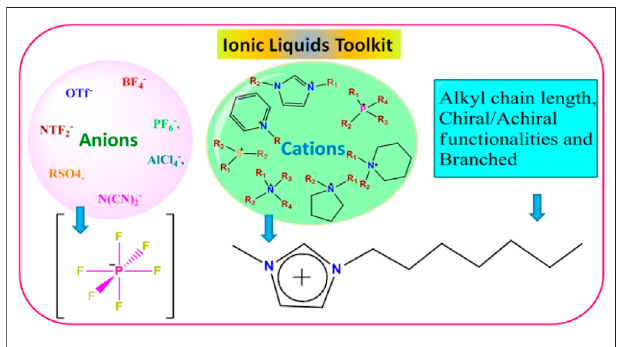
FIGURE 3 | Ionic liquids (ILs) toolkit consists of cations and